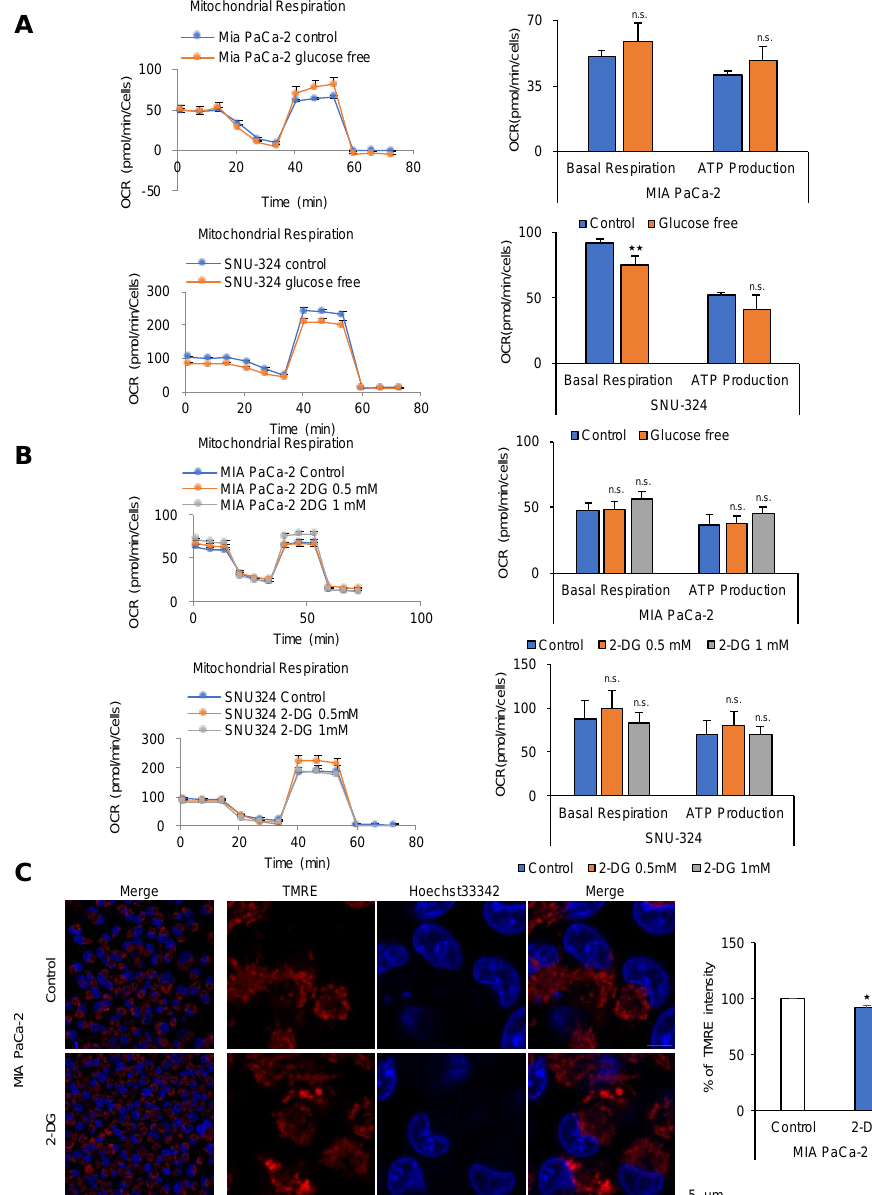
Figure 1. Glucose is not the ATP source in cancer cells. ( A ) Seahorse XF analysis of MIA PaCa-2 and SNU-324 cells treated sequentially with oligomycin, the chemical uncoupler FCCP, and antimycin A / Rotenone. The oxygen consumption rate (OCR) was determined using the Seahorse XFe96